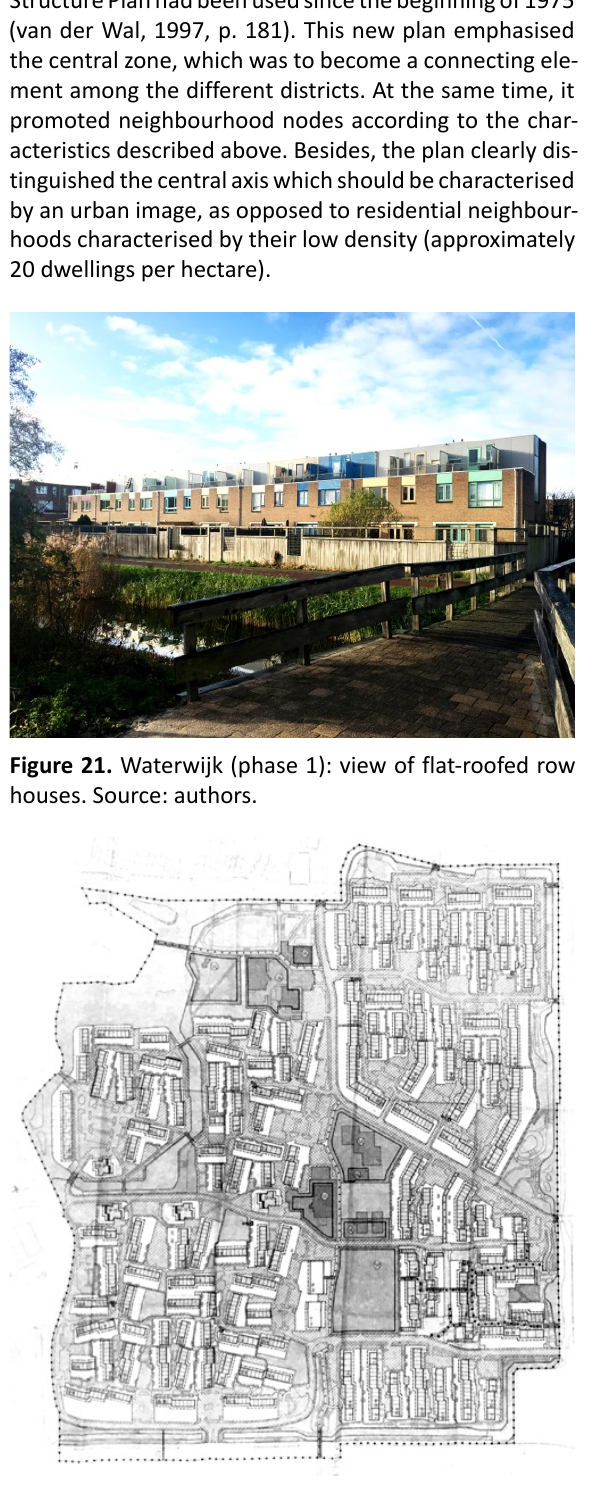
Figure 22. Boswijk’s urban layout. Source: Flevolands